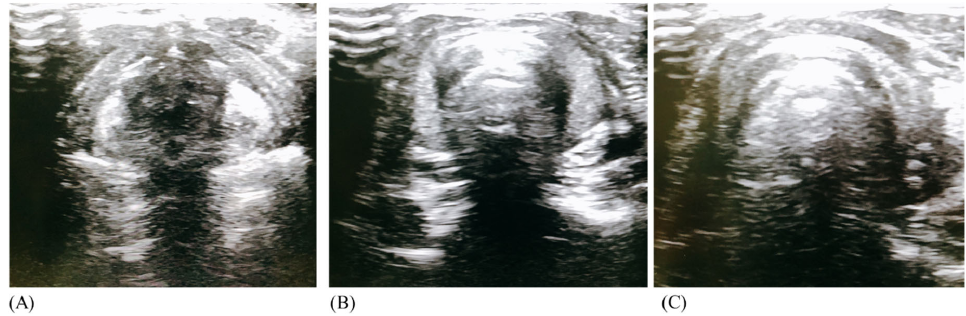
Figure 5. Sonographic appearance of ( A ) Thyroid cartilage ( B ) Cricothyroid membrane ( C ) cricoid cartilage.